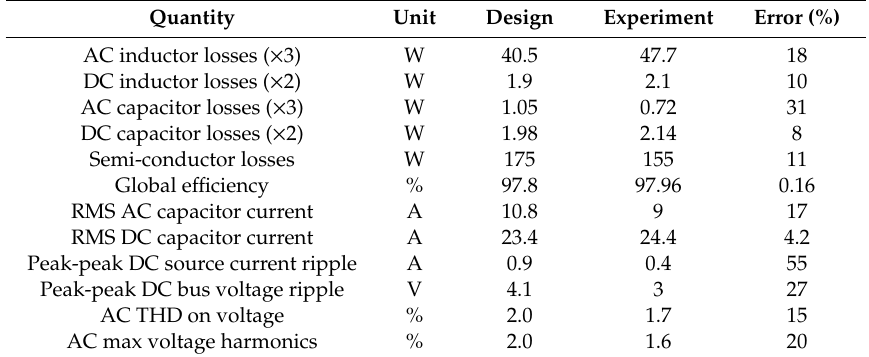
Table 5. Comparisons between optimization results and experiments for the ferrite core solution.